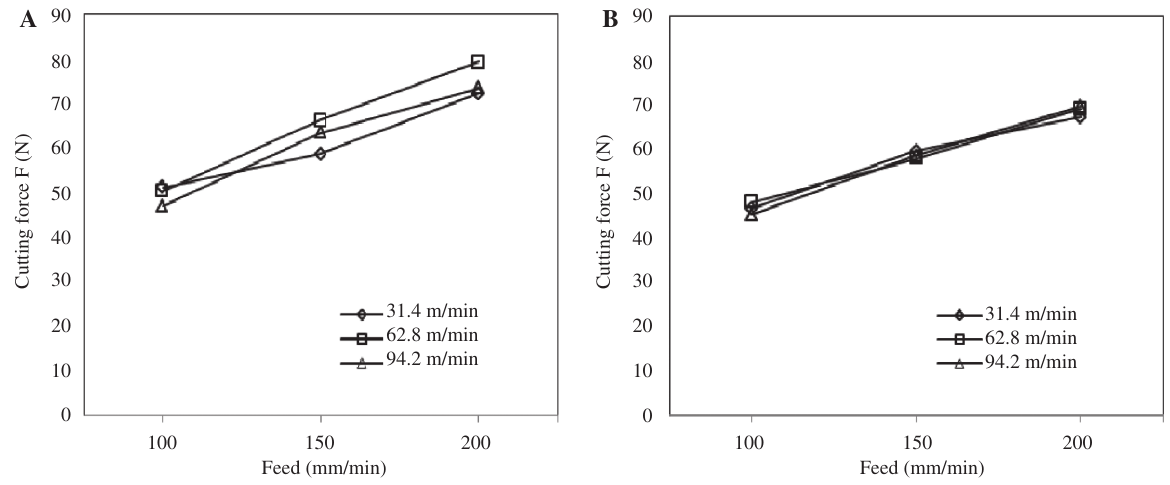
Figure 8 Influence of the cutting parameters on cutting force at different number of flutes: (A) three flutes and (B) four